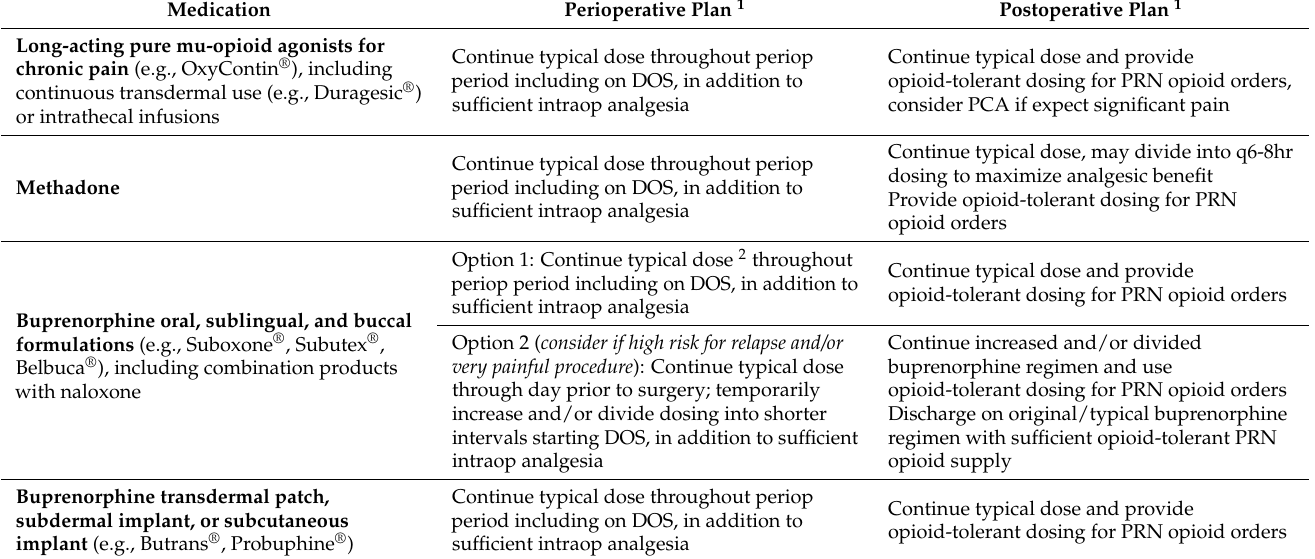
Table 3. Recommendations for Perioperative Management of Long-Acting Opioids and Medication Assisted Therapy (MAT). Medication Perioperative Plan 1 Postoperative Plan